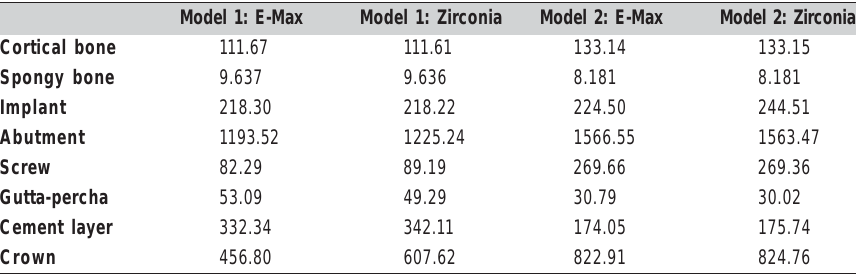
Table 3: Values of maximum Von Mises stresses [in MPa] induced in the side of load application under oblique loading condition in all